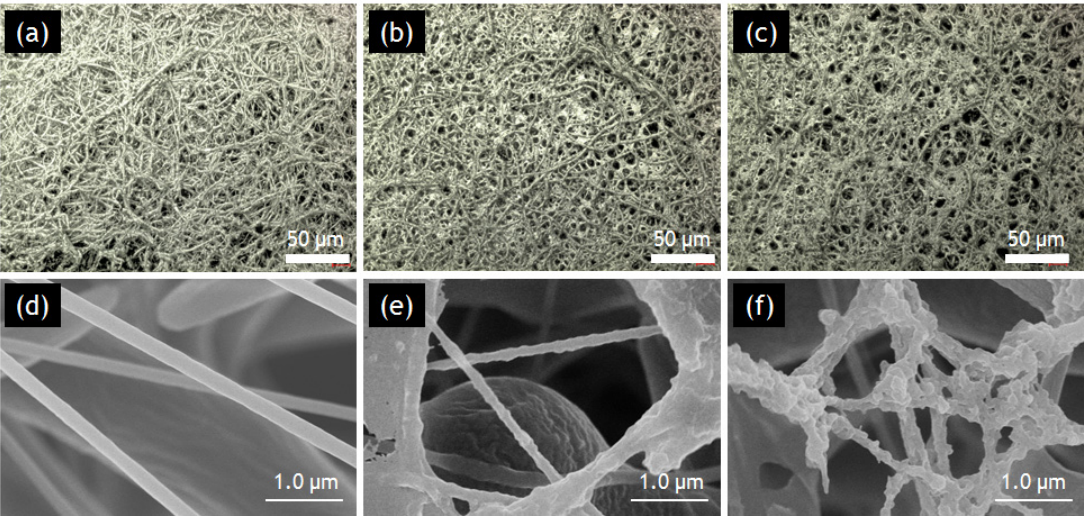
Figure 3. SLM ( a – c ) and SEM ( d – f ) images of PCL( a , d ), LbL coated ( b , e ), and HVJ-E coated PCL nanofibers ( c , f ).